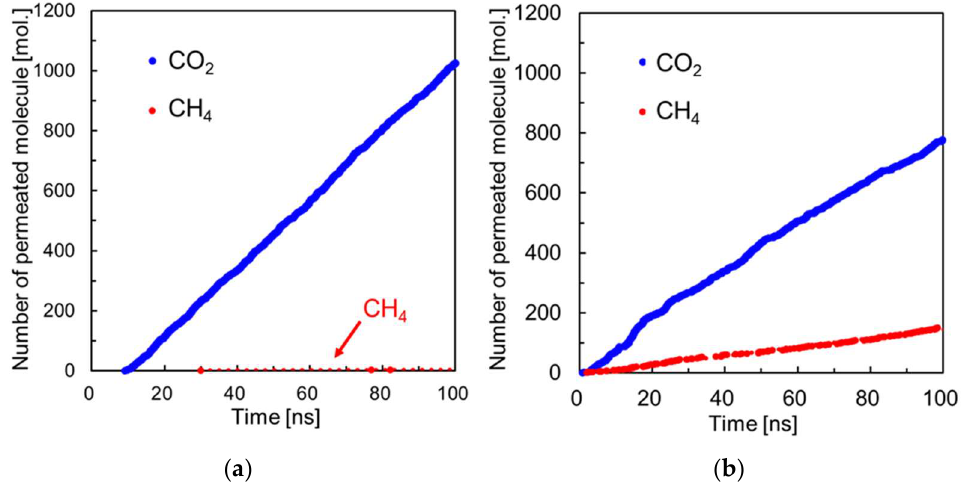
Figure 3. Changes in the number of permeated gas molecules through the perfectly crystalline model of CHA zeolite membrane. ( a ) 0.5 MPa, ( b ) 8.0 MPa.